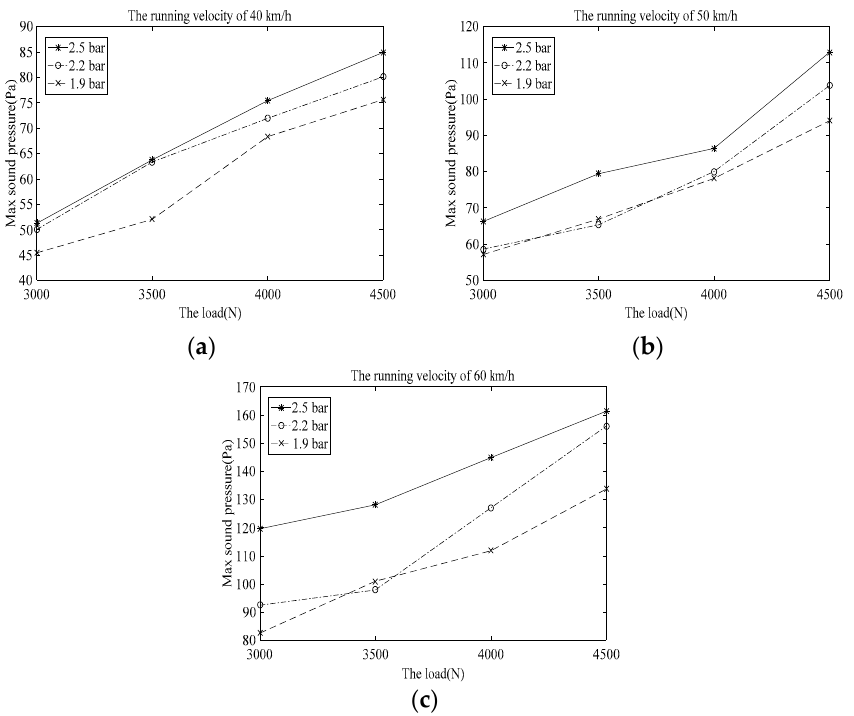
Figure 8. Variation of maximum acoustic pressure amplitudes with the various loads: ( a ) For the running speed of 40 km/h; ( b ) For the running speed of 50 km/h; ( c ) For the running speed of 60 km/h.